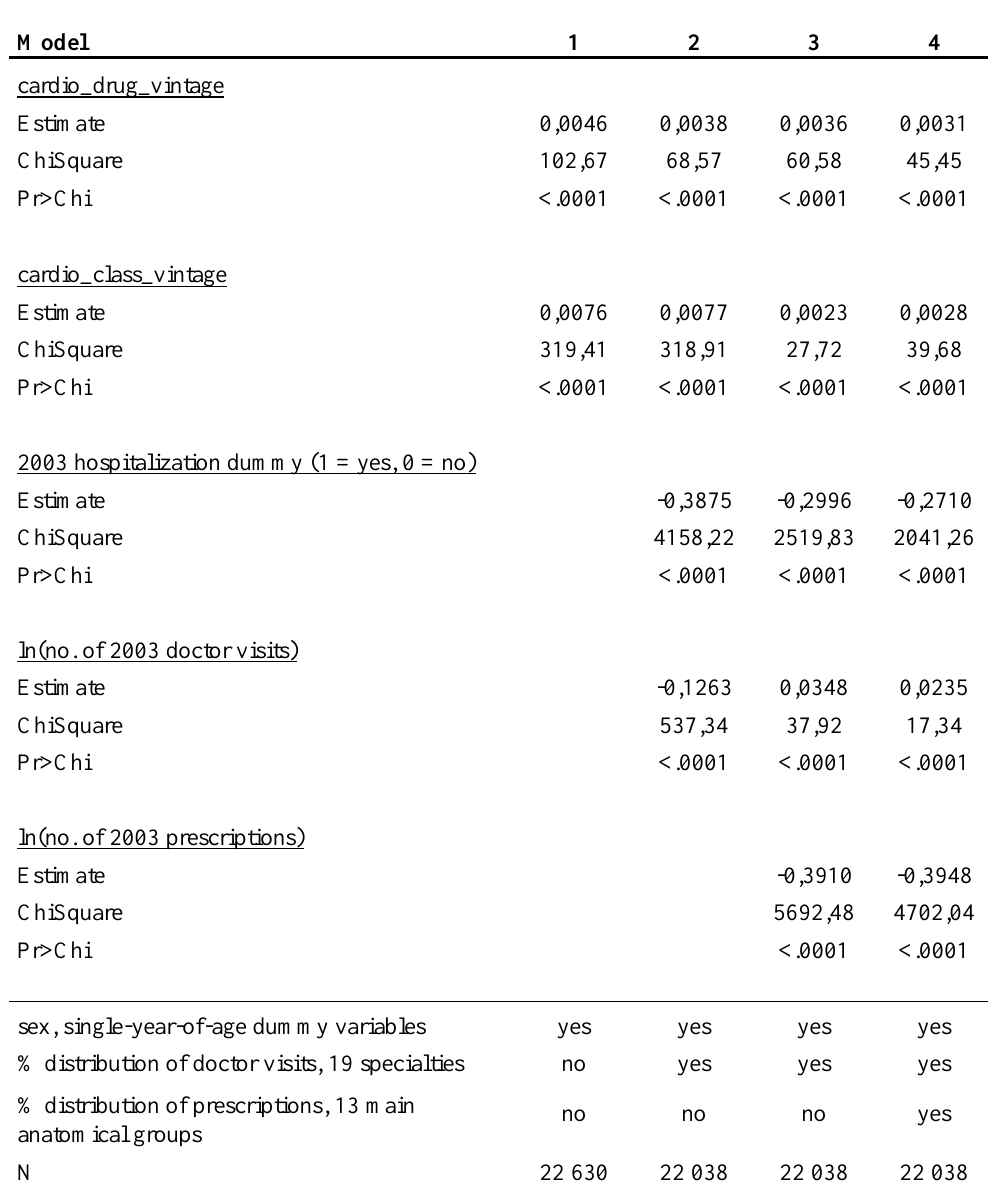
) =  cardio_drug_vintage i 